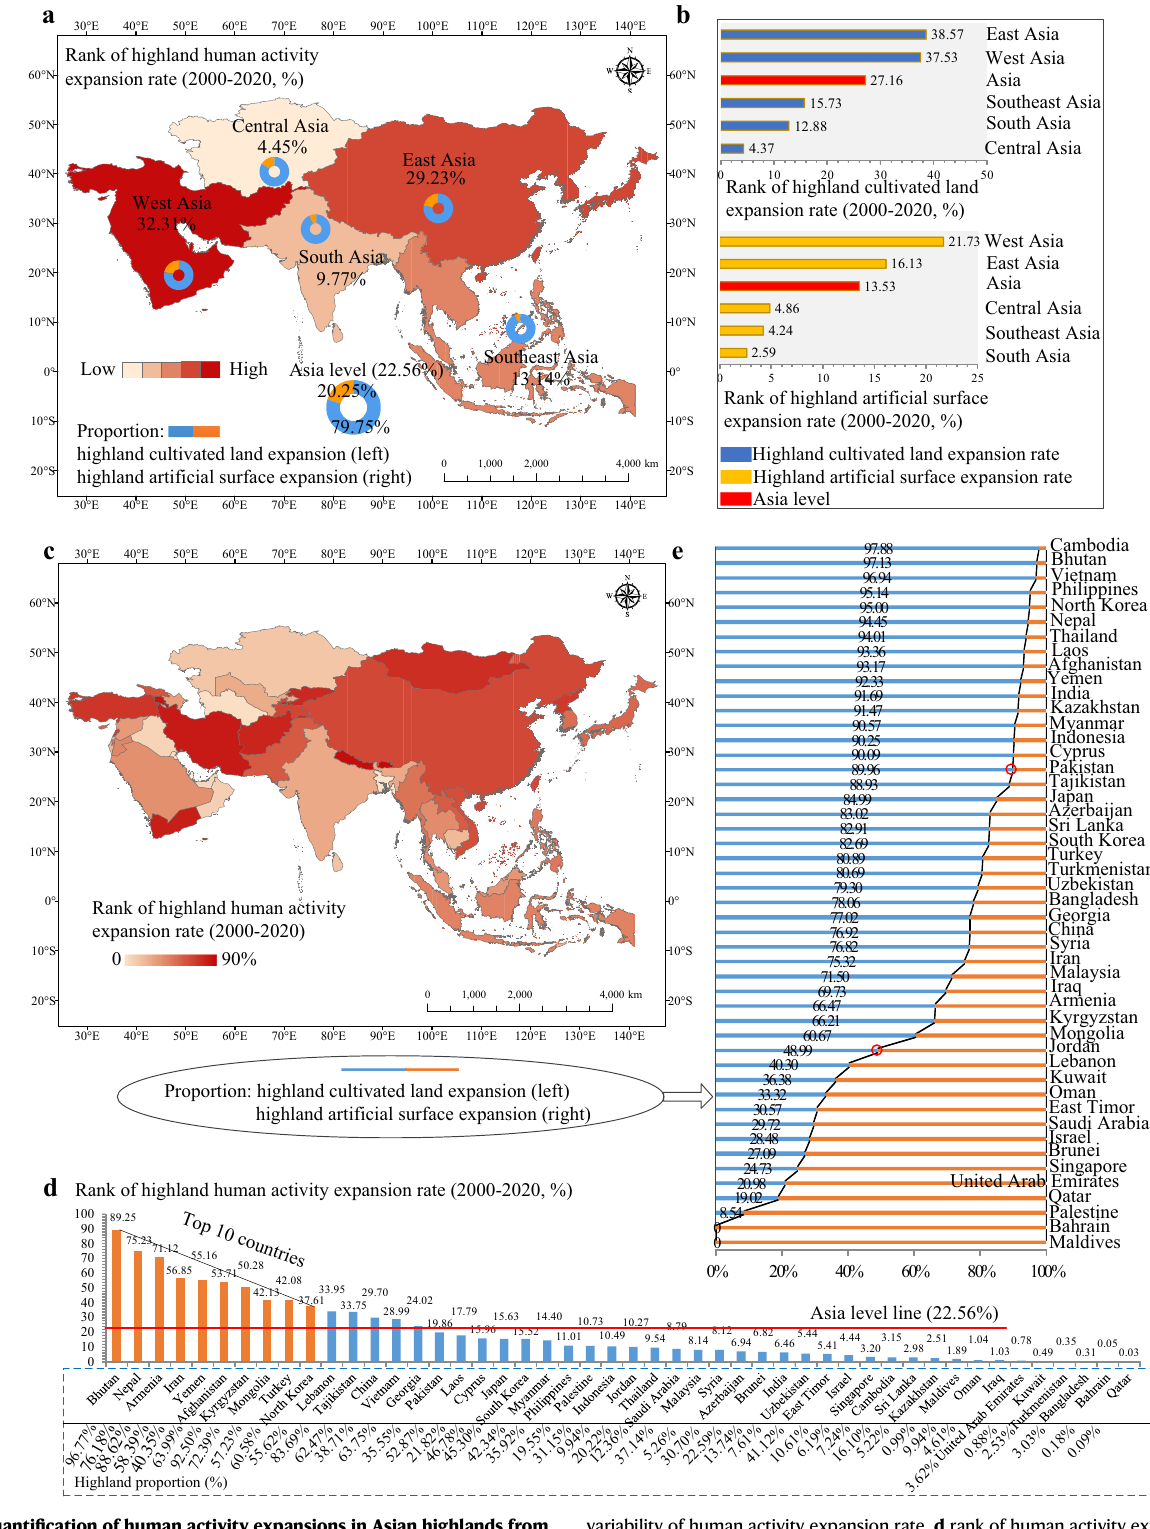
variability of human activity expansion rate, d rank of human activity expansion ratein48Asiancountriesand e proportionofhumanactivityexpansiontypesin48 Asian